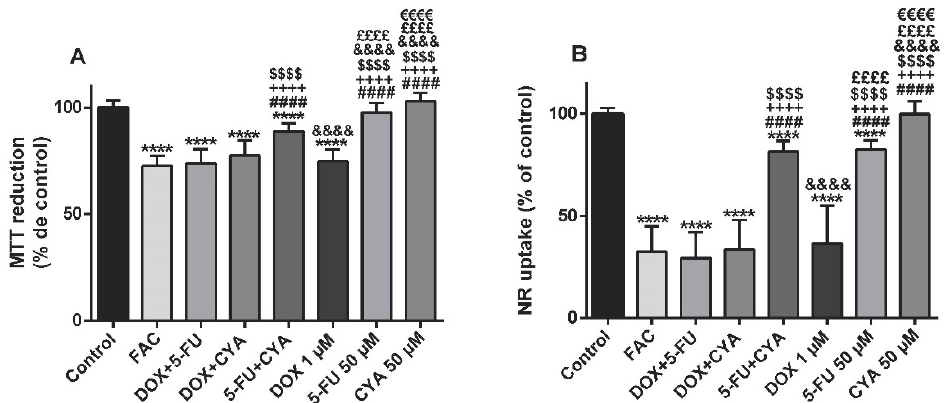
Figure 7. Mitochondrial and lysosomal dysfunction evaluated by the MTT reduction assay ( A ) and the NR uptake assay, ( B ) respectively, in differentiated H9c2 cells incubated with FAC, other mixtures of DOX (1 μ M), 5-FU (50 μ M) and CYA (50 μ M) and the drugs alone for 48 h. Results are presented as mean ± SD of 4–6 independent experiments (total of 16–28 wells). Statistical analyses were